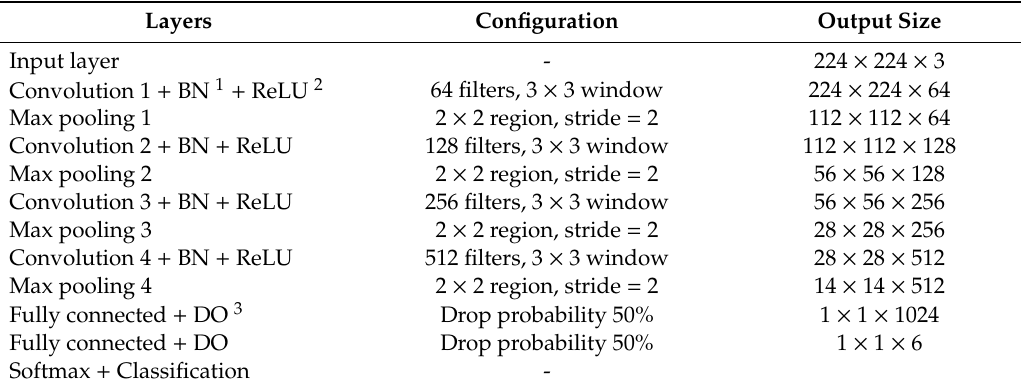
Table 2. Layers of CNN6 and their configurations.